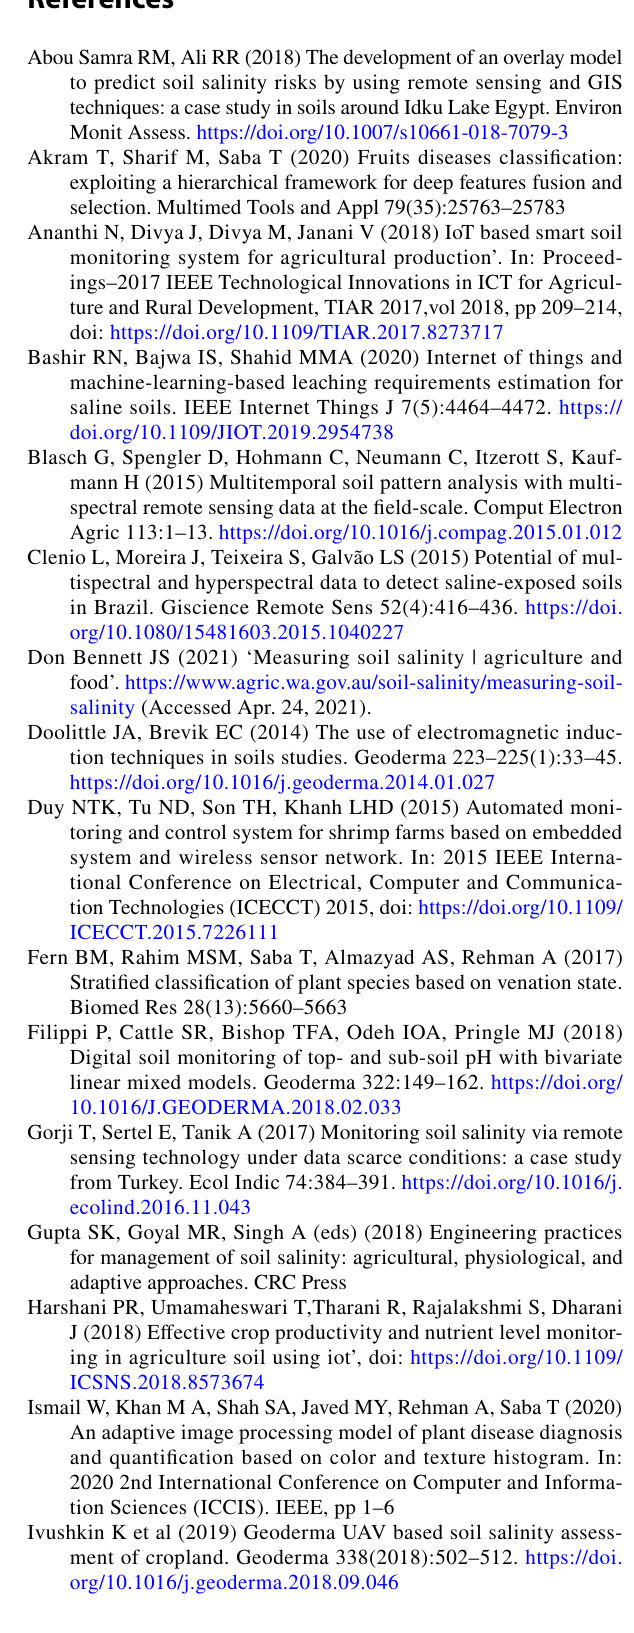
Number of sample